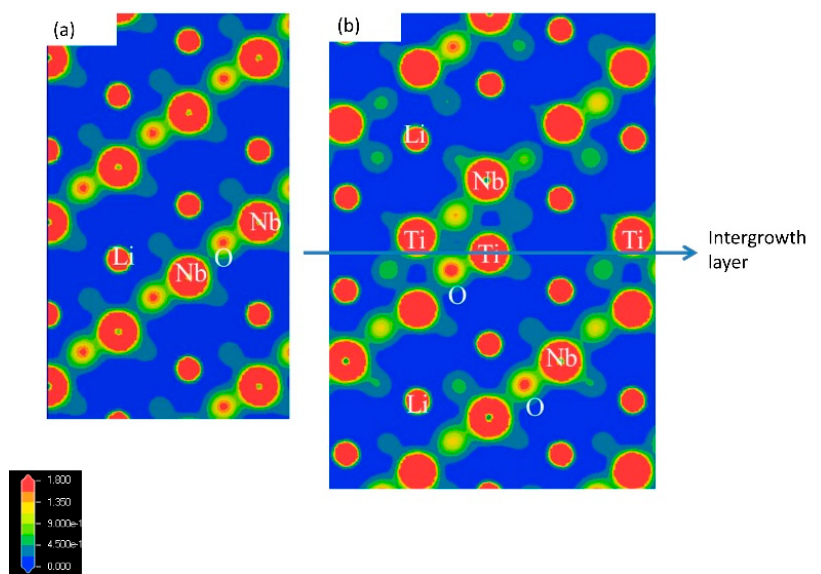
Figure 10. Electron density maps of LiNbO 3 in ( a ) and Li 9.5 Nb 4.4 Ti 7.1 O 30 in ( b ) taken from the [100] by the first-principles molecular dynamics simulation [15].